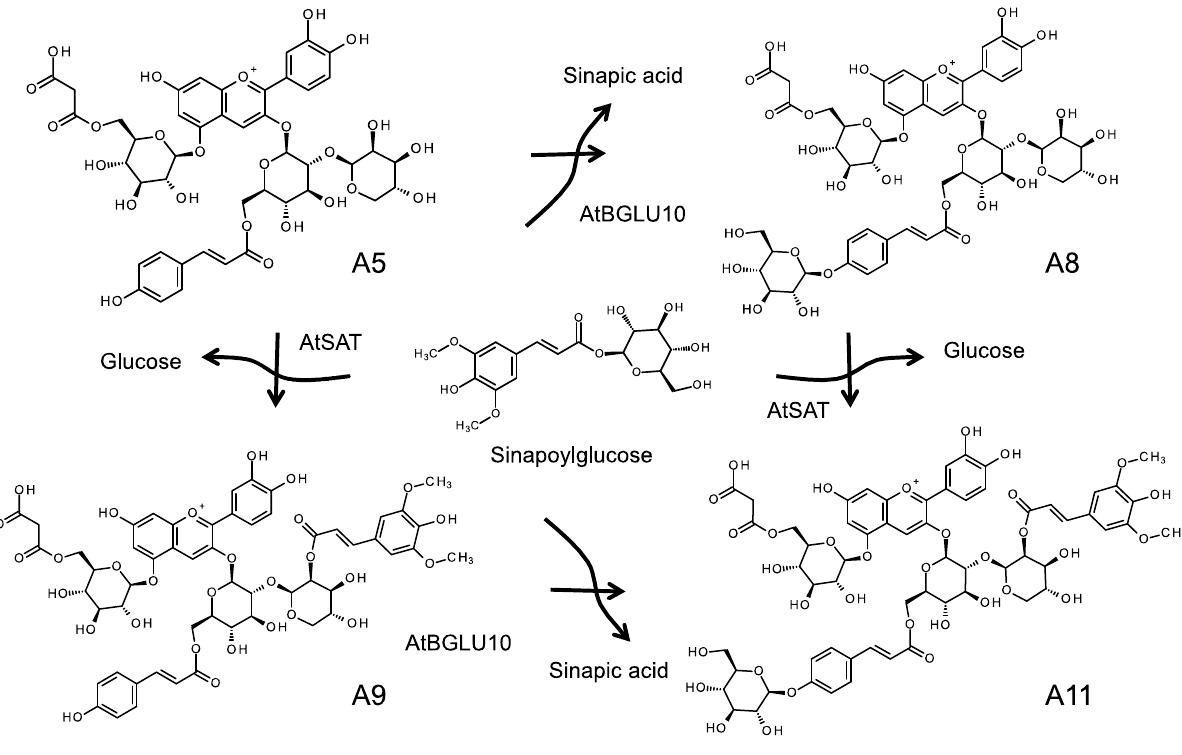
Figure 8. Sinapoylation and the glucosylation of the p -coumaroyl moiety on the anthocyanin A11 is catalyzed by enzymes using sinapoylglucose as a Zwitter donor in Arabidopsis .